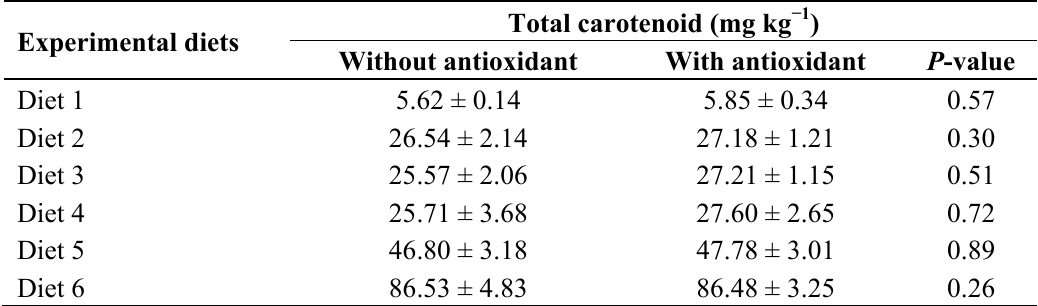
Mean with the different letters in same row are significantly different at p ≤